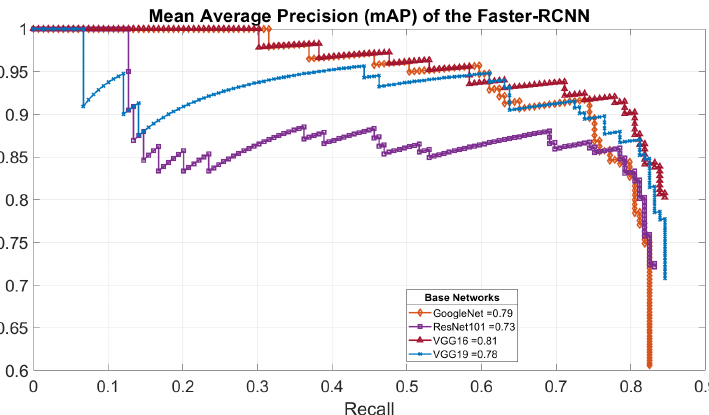
Figure 9. Mean average precision of our insect detector after training for 350 epochs with the most successful feature extractor.